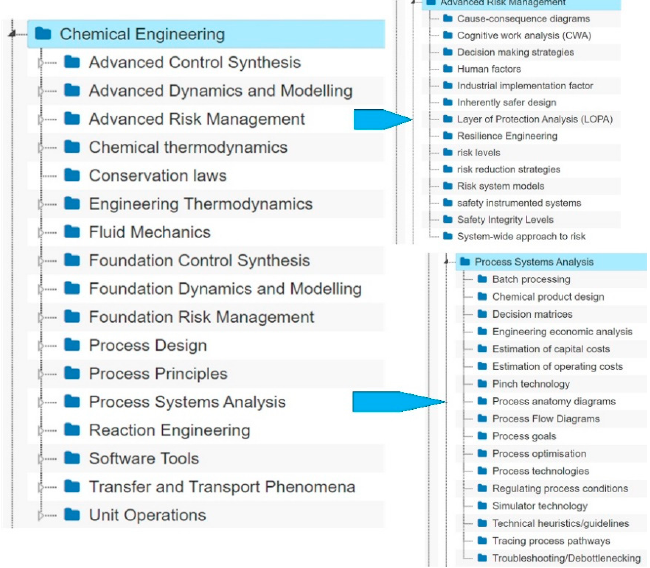
Figure 5. Knowledge taxonomies for Chemical Engineering (domain/sub-domain/topic).